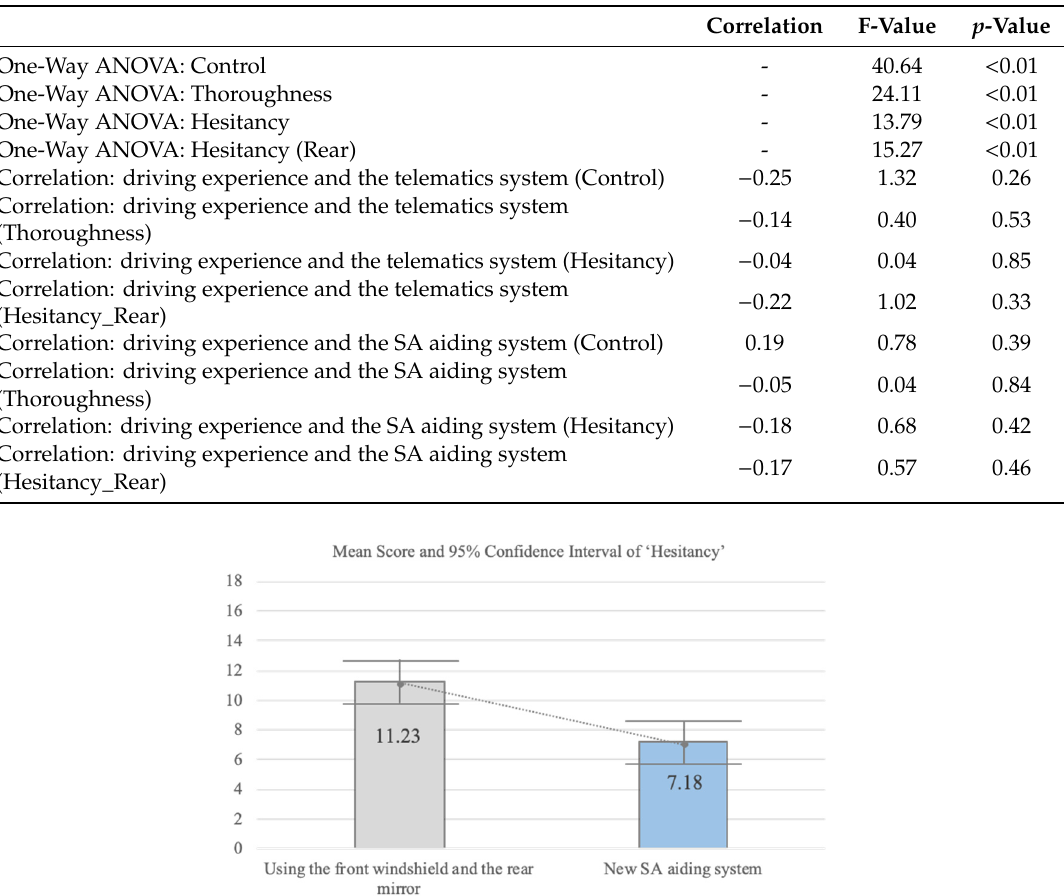
Table 4. ThestatisticalanalysisofDMQscores: One-wayANOVAandthecorrelation(Source: Owncreation).